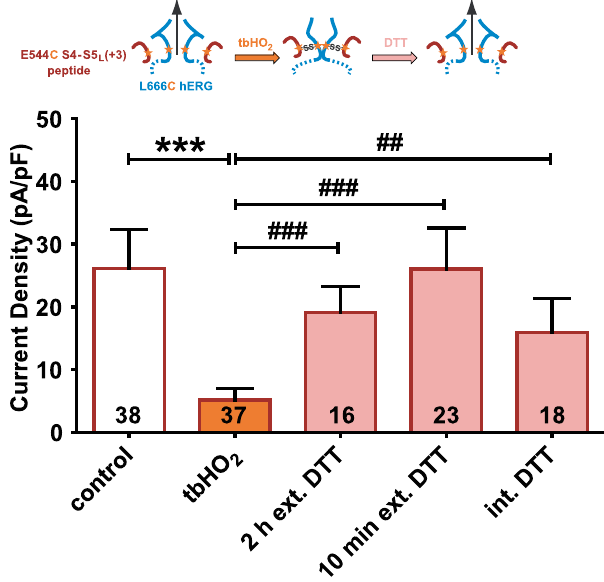
Figure 6. hERG inhibition provoked by E544C S4-S5 L ( + 3) peptide covalent binding to L666C mutant channel is reversible. Mean hERG tail-current density at − 40 mV after a prepulse at + 100 mV of L666C hERG channels in the presence of E544C S4-S5 L ( + 3) peptide (1 µ g L666C hERG plus 3 µ g peptide plasmids) after 2 h incubation in Tyrode without (control) or with 0.2 mM tbHO 2 (control and tbHO 2 , respectively, same results as in Fig. 5B), and after 2 h or 10 min incubation in 10 mM DTT following tbHO 2 incubation, or after direct application of 10 mM DTT in the pipette tip, following tbHO 2 incubation. *** p < 0.001 versus control,